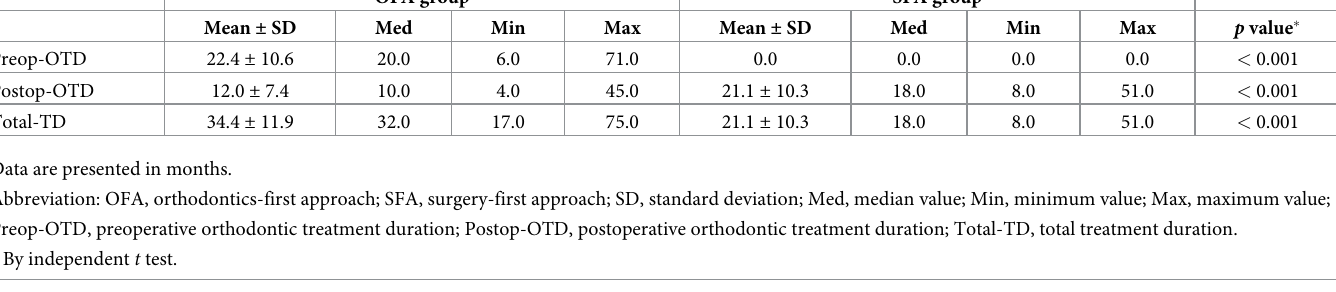
Table 8. Comparison of treatment durations between orthodontics-first approach and surgery-first approach groups. OFA